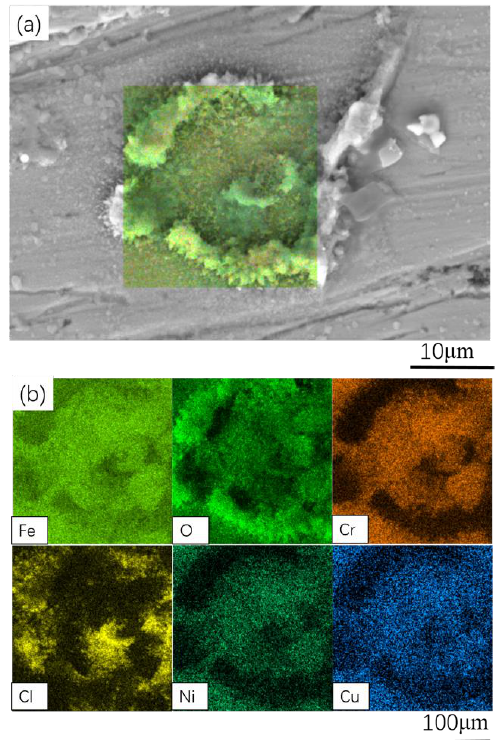
Figure 1. ( a ) SEM and ( b ) EDS mapping results of 304Cu pits after a 480 h salt spray test in 5 wt.% NaCl at 35 ± 2 °C.